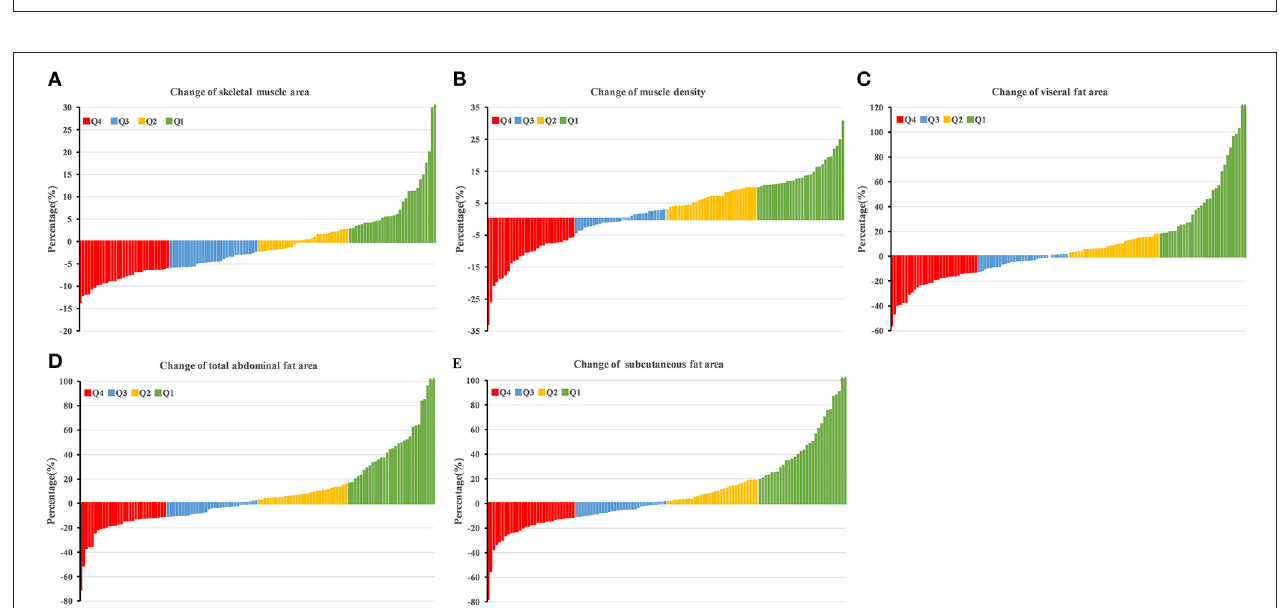
FIGURE 2 | Change of skeletal muscle area (A) , muscle density (B) , visceral fat area (C) , total abdominal fat area (D) , subcutaneous fat area (E) during NCRT. Q1, Q2, Q3, and Q4 have represented the highest quartile, 50–75%, 25–50%, and lowest quartile,